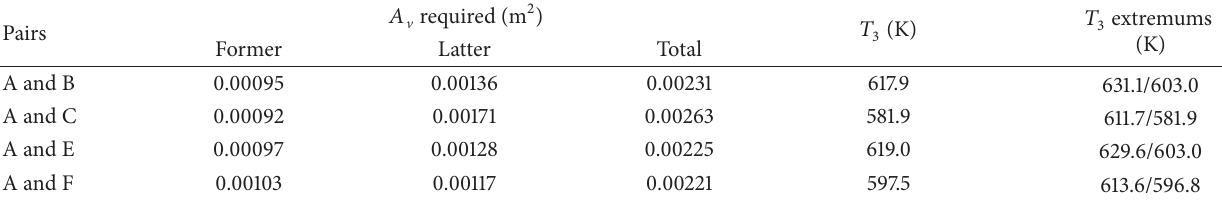
Table 3: Steady-state features opening dual bypass valves to 0 power output.